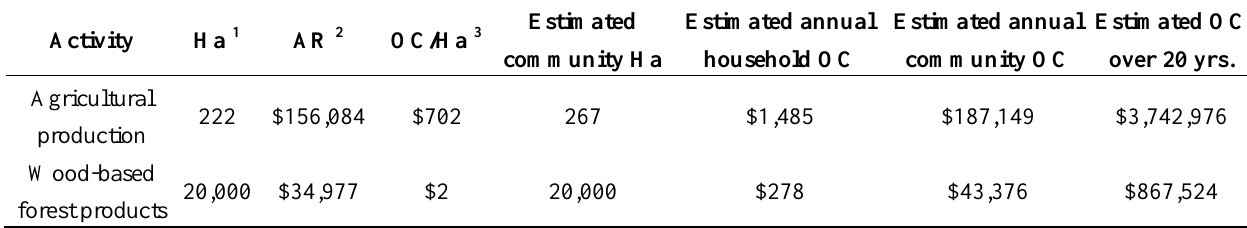
Table 3. OCA for subsistence activities in Nueva